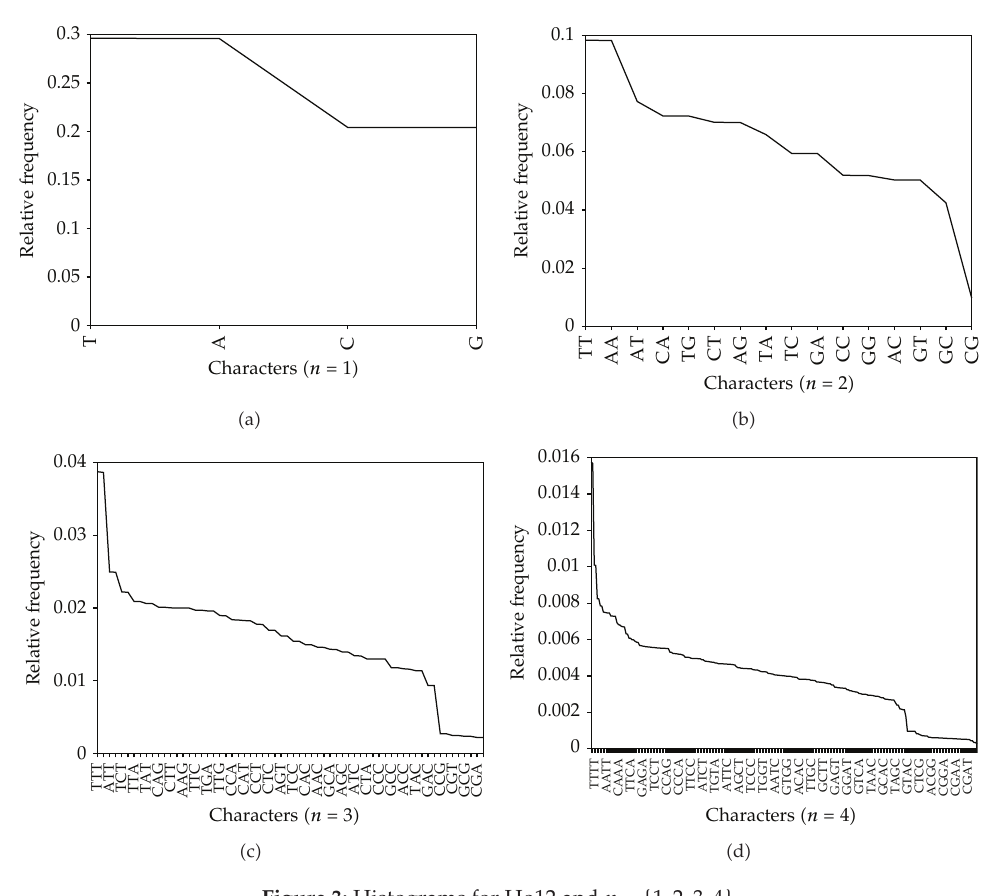
Figure 3: Histograms for Ho12 and n (cid:7) { 1 , 2 , 3 , 4 }